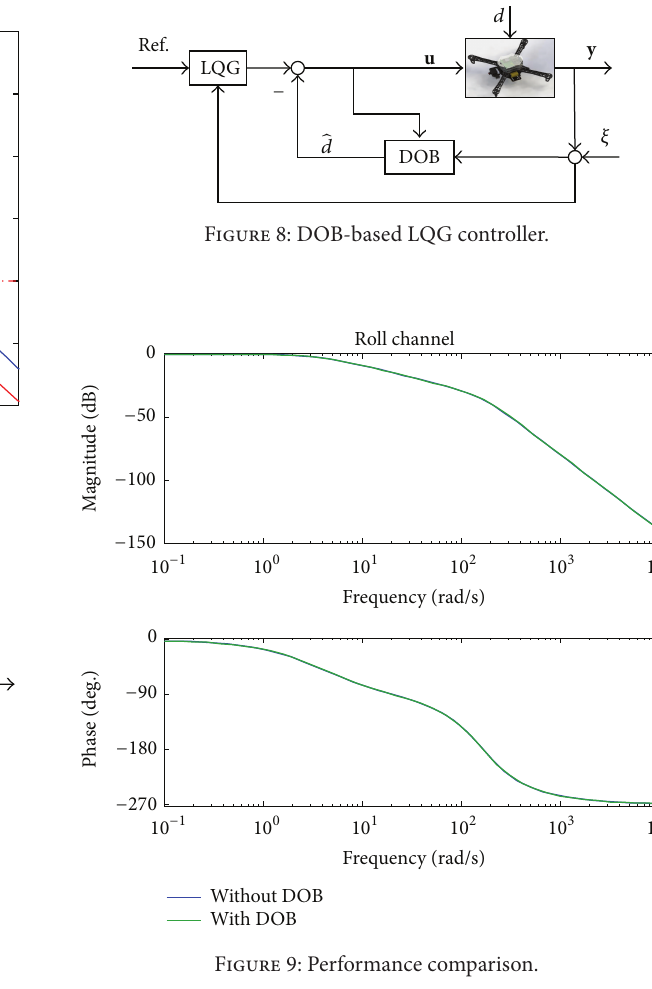
Figure 9: Performance